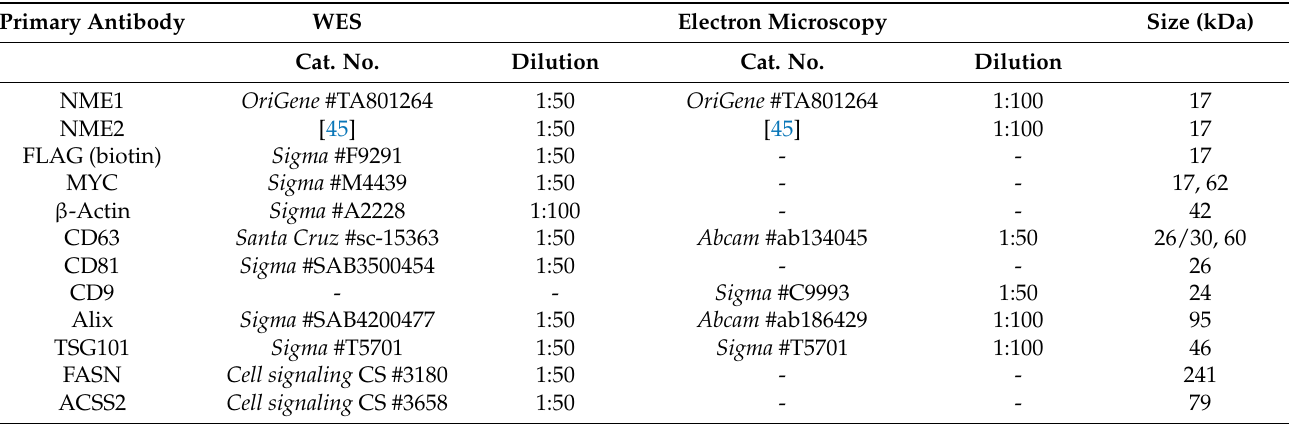
Table 1. List of the used primary antibodies (catalogue numbers, dilutions and expected sizes for WES analyses were